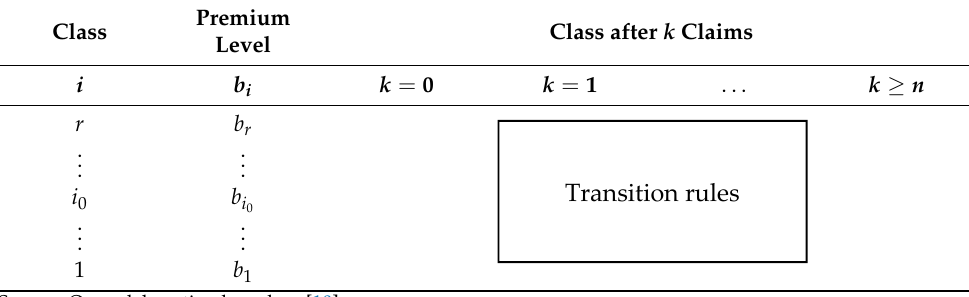
Table 1. Elements of a bonus-malus system (BMS).